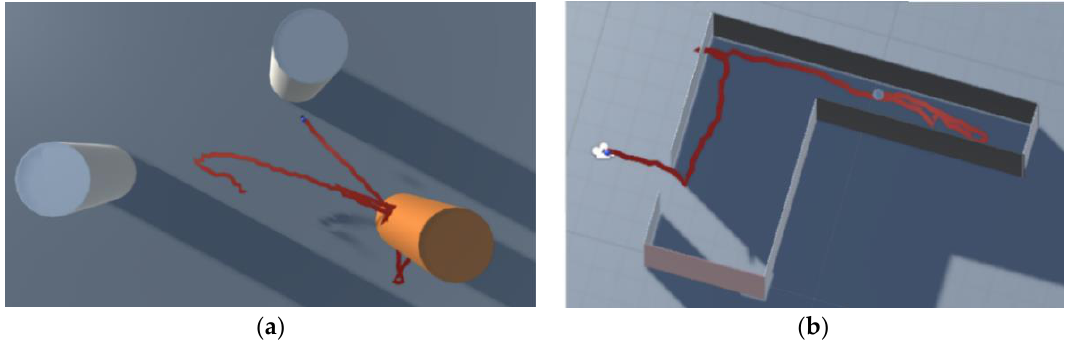
Figure 7. Screenshots of the route followed by a test subject in tests 1 ( a ) and 3 ( b ).